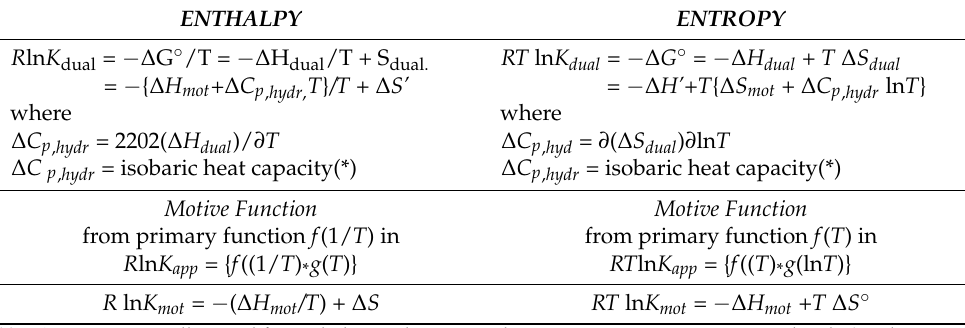
Table 2. Convoluted binding functions. Motive functions.